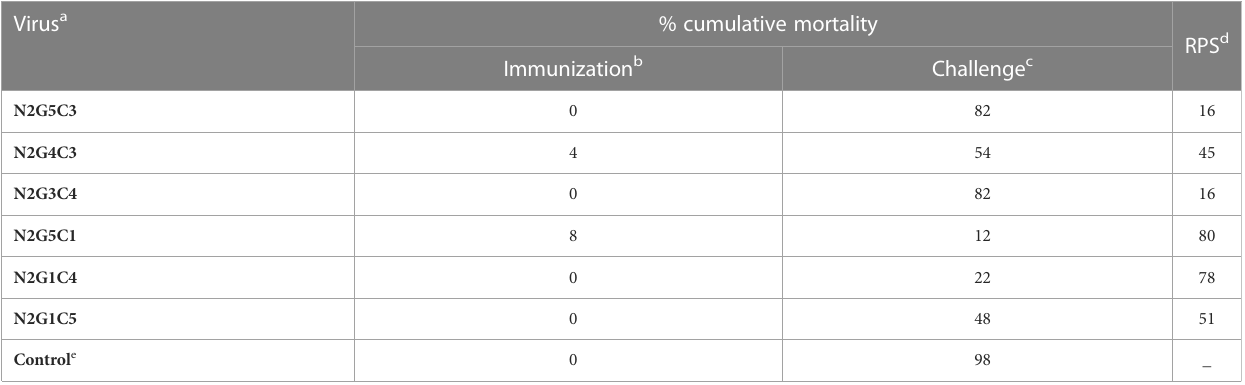
TABLE 1 Summary of percent cumulative mortality observed in trout infected by rVHSVGO-LinkerP2NNV and challenged by VHSV. Virus a % cumulative mortality